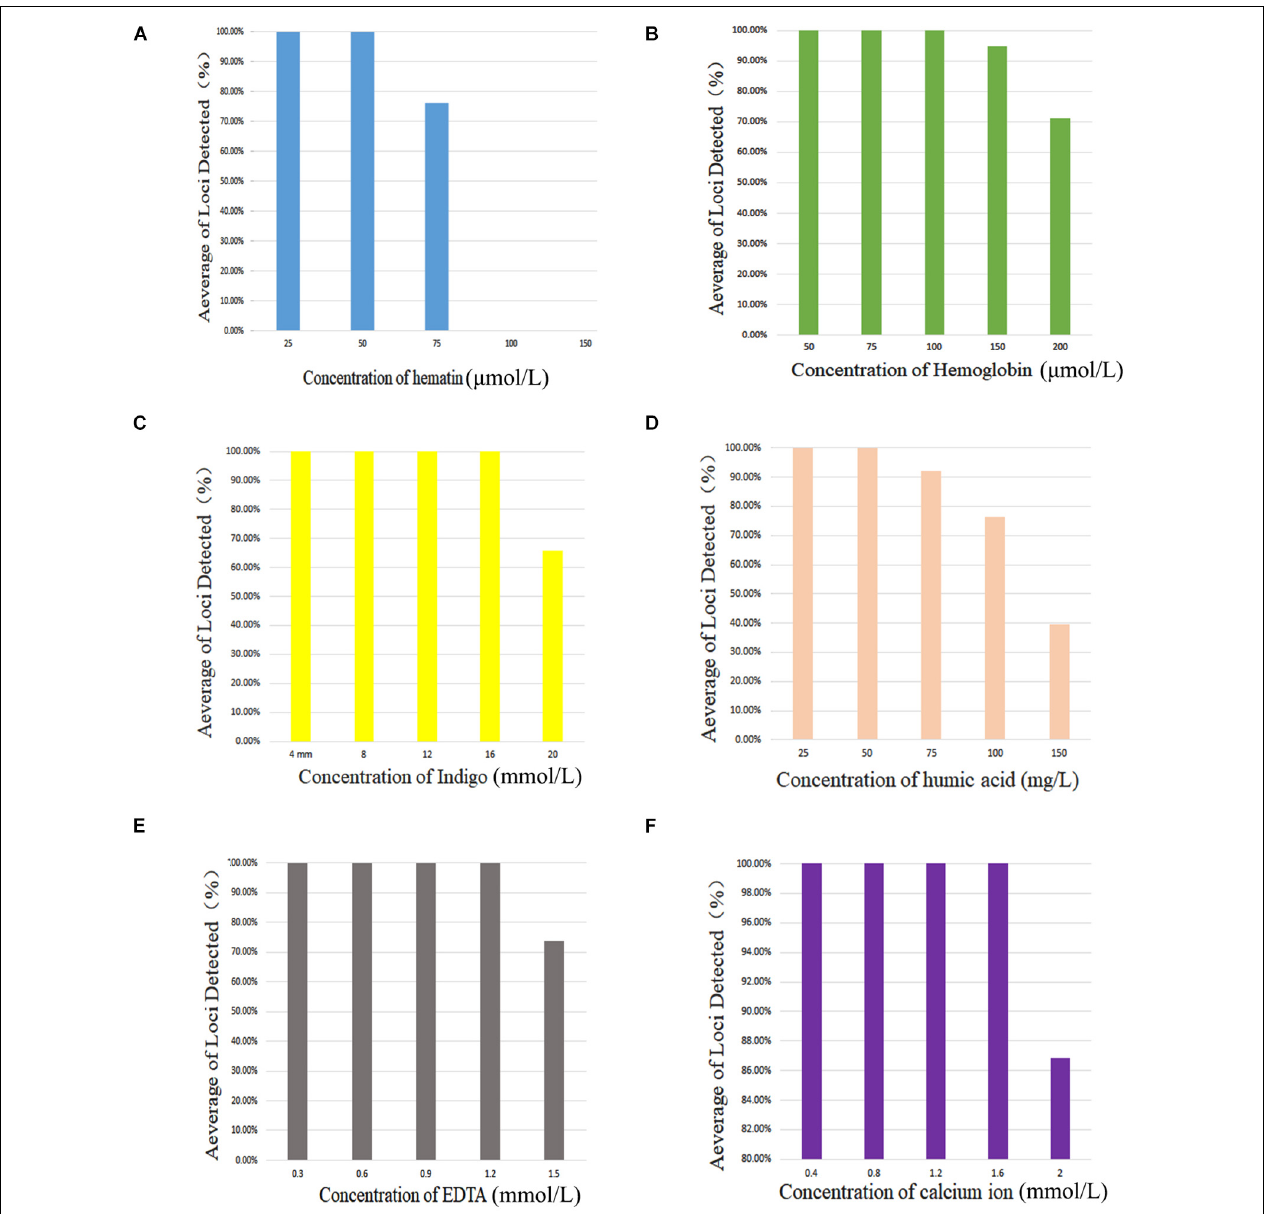
FIGURE 2 | Average of loci detected with AGCU X-InDel 38 kit with increasing concentration of PCR inhibitors. (A) Amplification results at different concentrations of hematin, (B) hemoglobin, (C) indigo, (D) humic acid, (E) EDTA, and (F) calcium